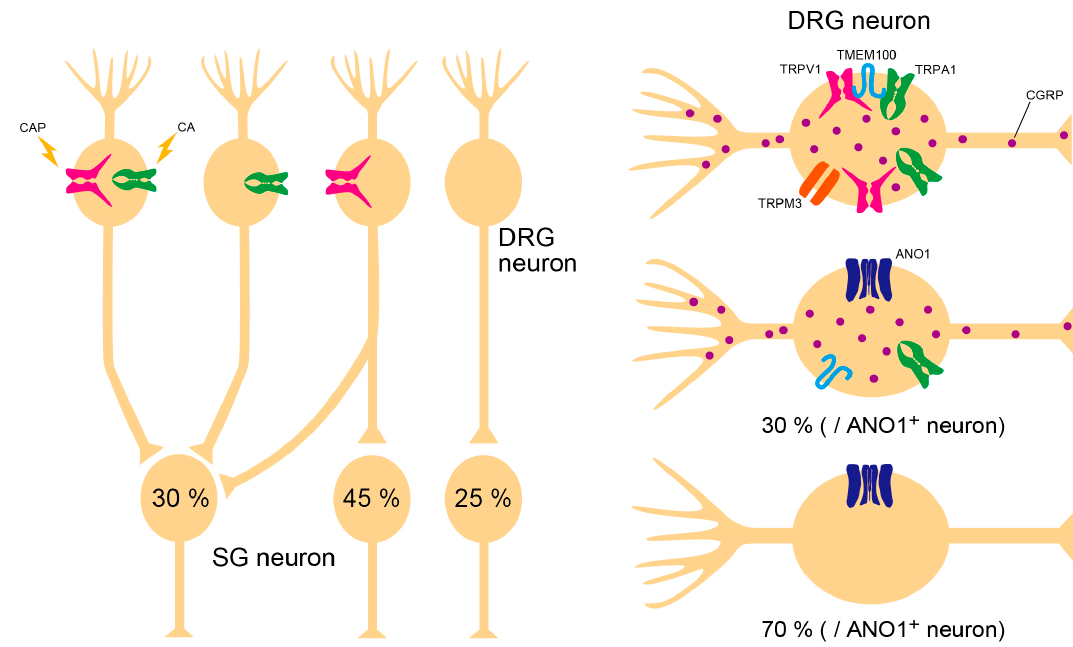
Figure 1. Nociceptor populations in substantia gelatinosa (SG) neurons of lamina II, which receive nociceptive inputs from dorsal root ganglion (DRG) neurons, no neurons respond only to TRPA1-associated stimuli. Approximately 30% of SG neurons are double-positive to capsaicin (CAP) and cinnamaldehyde (CA), 45% of SG neurons response to only CAP, and 25% of neurons show no effect to either CAP or CA. There are calcitonin gene-related peptide (CGRP)-positive and -negative neurons in peripheral sensory nerves. Most TRPV1–TMEM100–TRPA1 complexes and TRPV1–TRPA1–TRPM3 trios are expressed in CGRP-positive neurons. Anoctamin 1 (ANO1) is also expressed in CGRP-positive neurons, however approximately 70% of ANO1-expressing neurons are CGRP-negative.